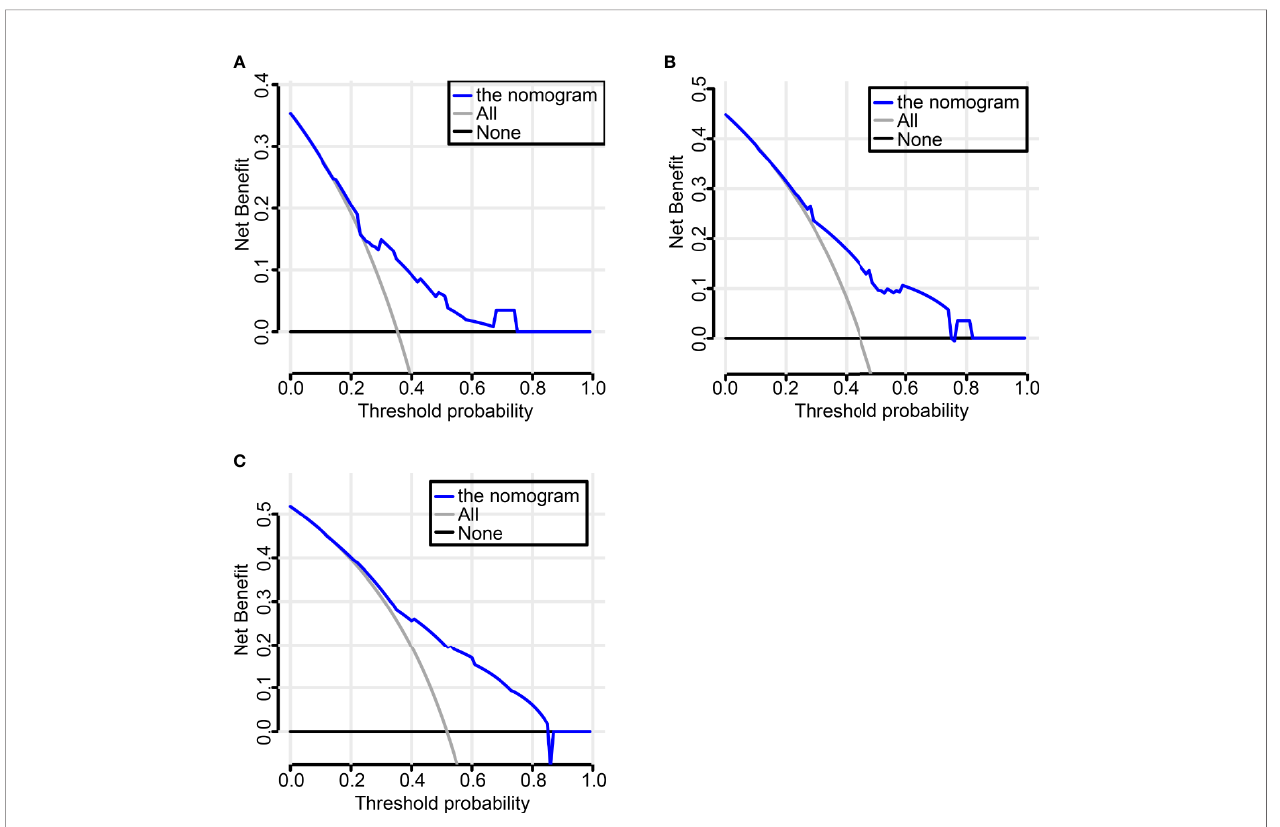
FIGURE 7 | Decision Curve Analysis (DCA) to evaluate clinical utility of the nomogram. The y-axis measures the net bene fi t. The dashed line represents the nomogram. Using the IHC-based nomogram provides a better net bene fi t than all or no treatment (A – C)